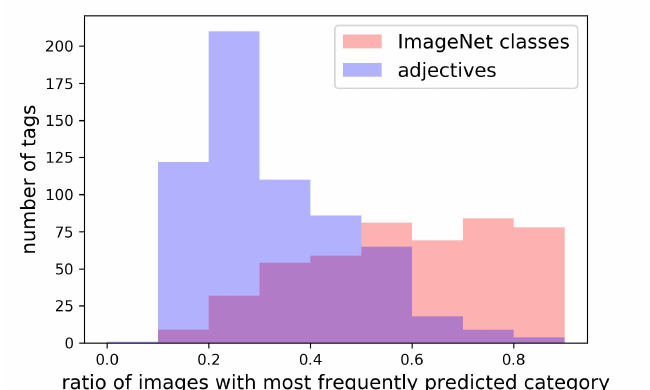
Figure 9. Ratio of images with most frequently predicted category for each concept.